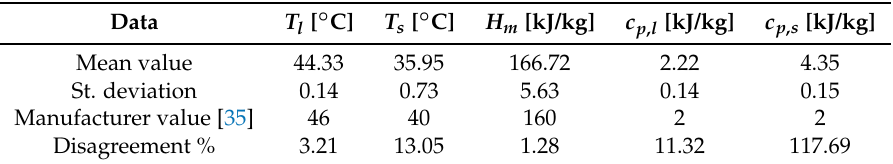
Table 2. Determination of thermal properties with T-history to RT45 paraffin.